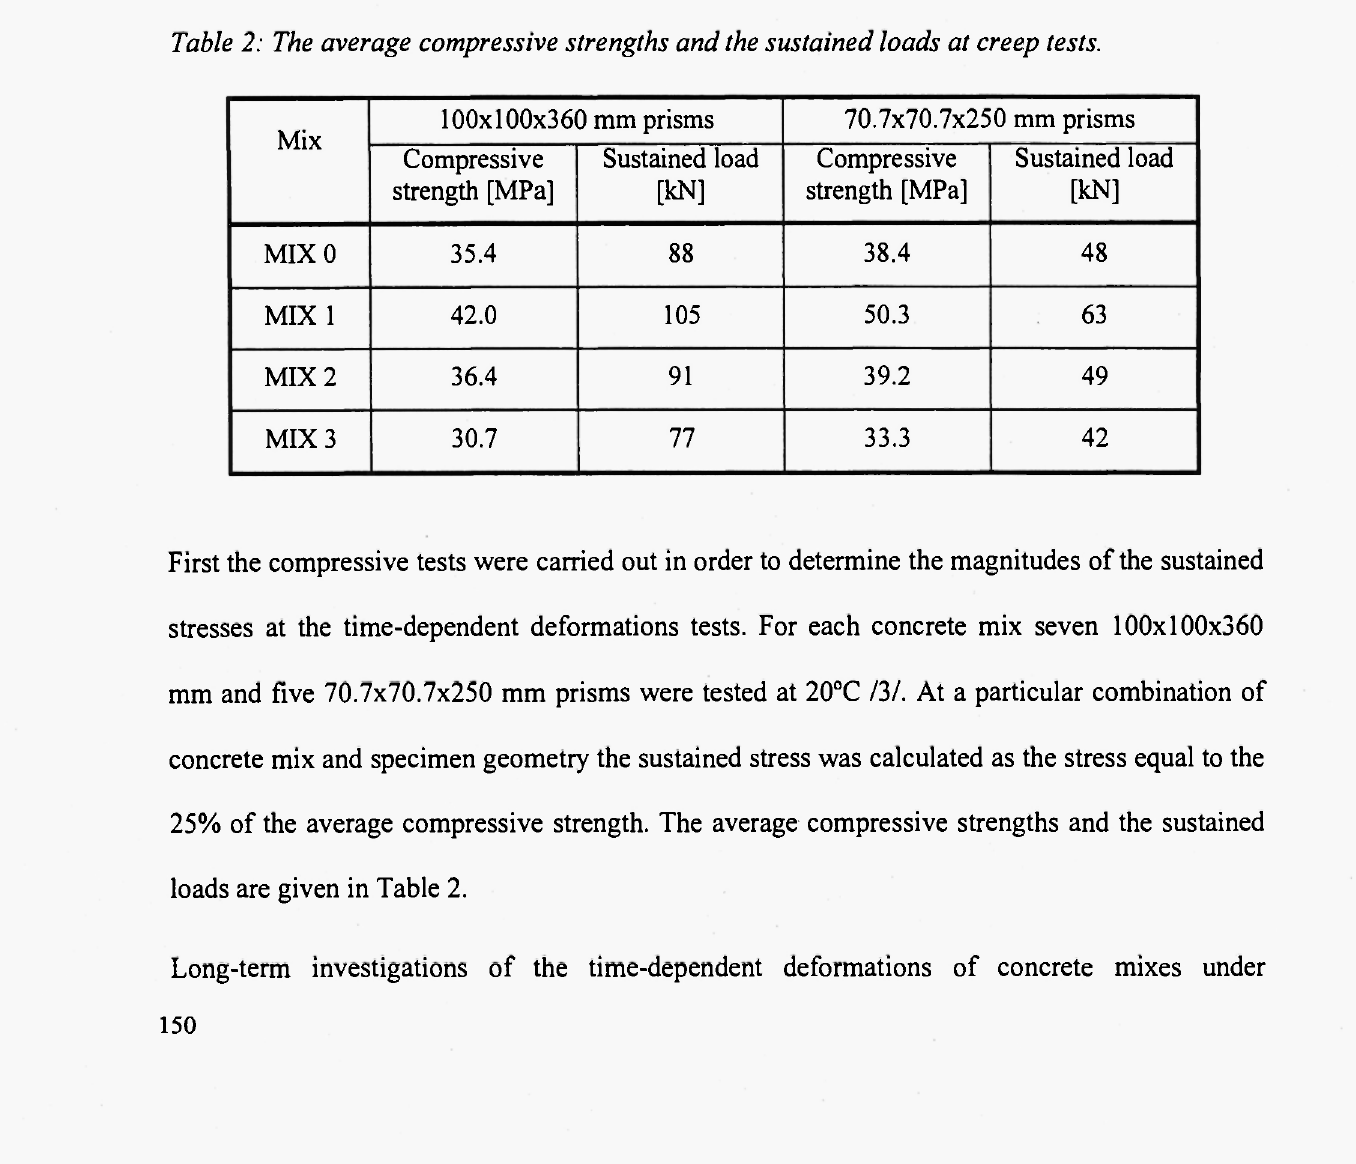
Table 2: The average compressive strengths and the sustained loads at creep